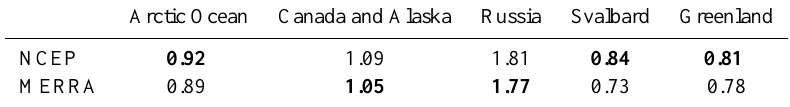
Table 4. Observation-to-model ratios between observations and model results from NCEP and MERRA runs over each Arctic sector. Arctic